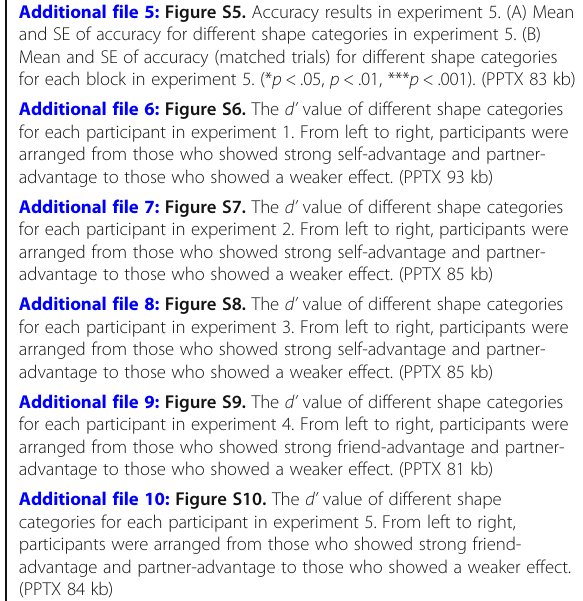
Additional file 5: Figure S5. Accuracy results in experiment 5. (A) Mean and SE of accuracy for different shape categories in experiment 5. (B) Mean and SE of accuracy (matched trials) for different shape categories for each block in experiment 5. (* p < .05, p < .01, *** p < .001). (PPTX 83 kb) Additional file 6: Figure S6. The d ’ value of different shape categories for each participant in experiment 1. From left to right, participants